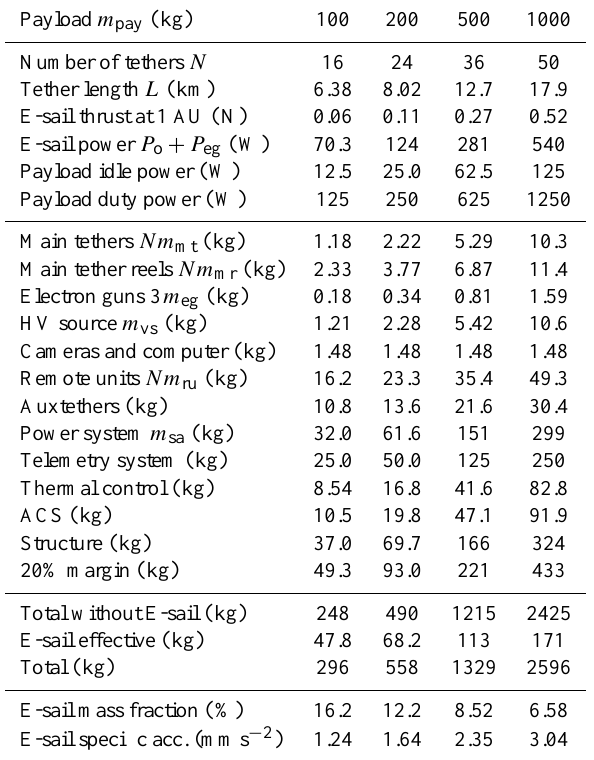
Table 4. Same as Table 2, but for a characteristic acceleration a ⊕ = 1mms − 2